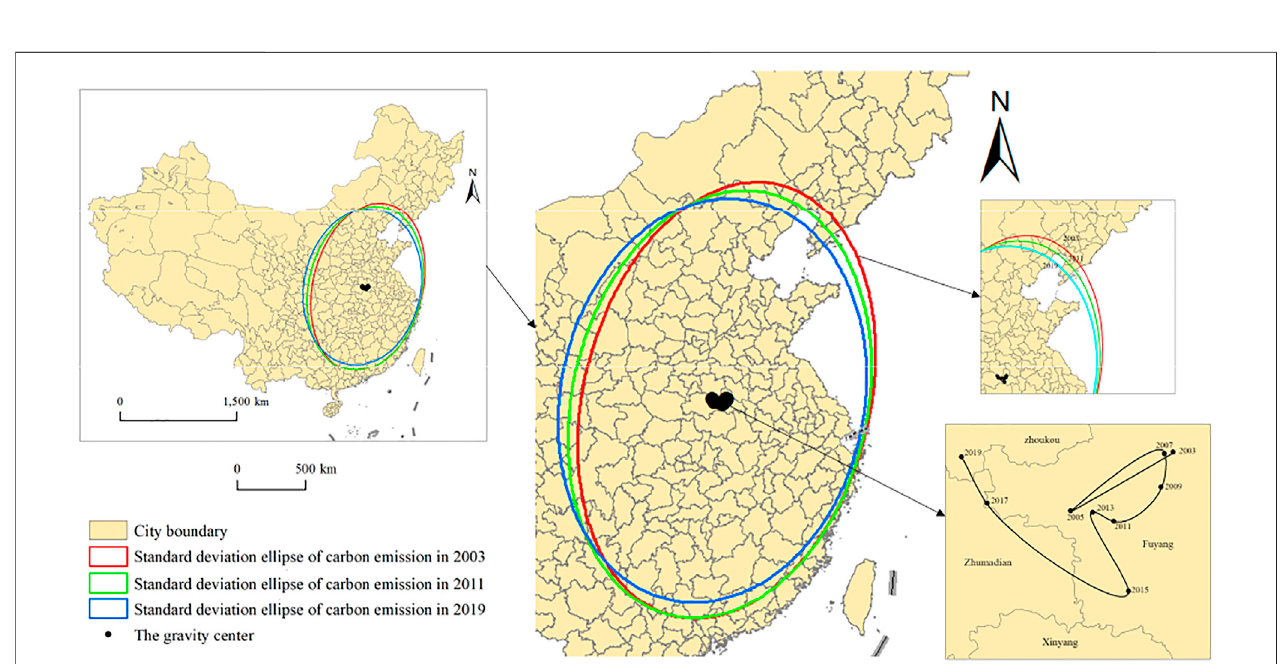
FIGURE 4 | Center of gravity migration of carbon emission in China from 2003 to